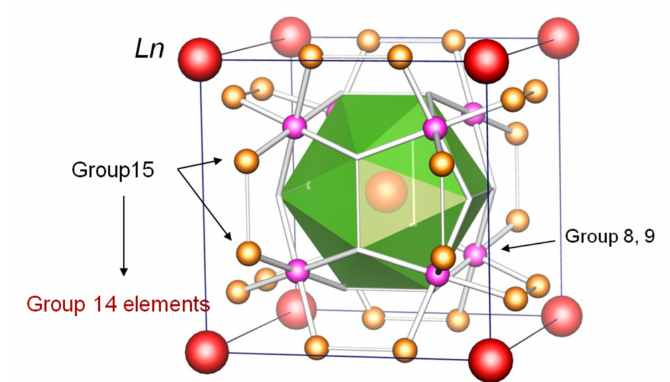
Figure 3. Crystal structure of the filled skutterudite compounds. In the present study, Ln sites are occupied by La, Ce, Pr, and Nd. The group 15 element is antimony, a part of which is substituted with germanium atoms. The transition metal sites are occupied by cobalt atoms.